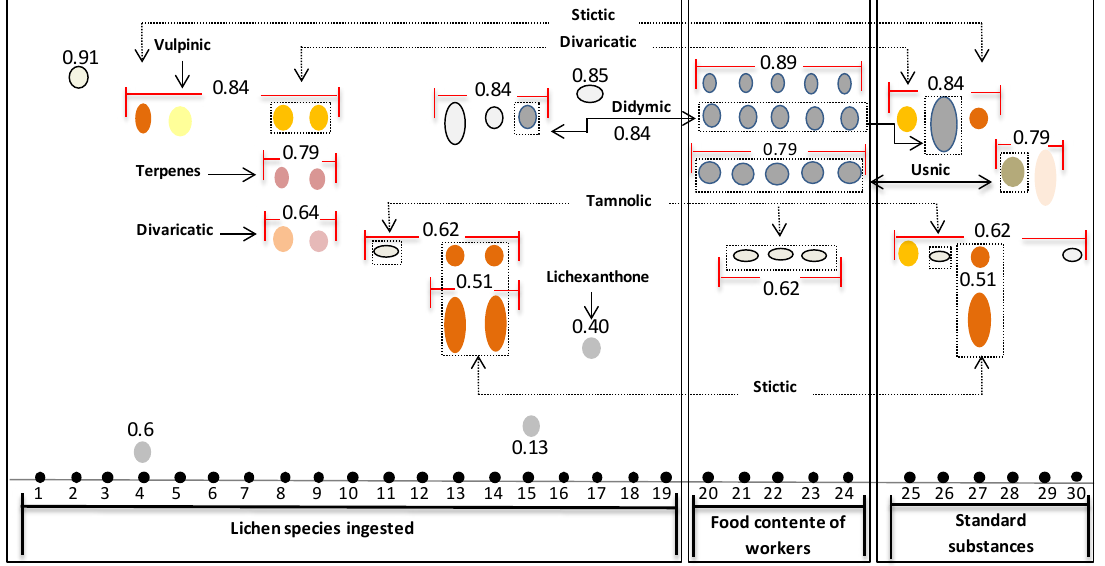
Fig 3. Thin layer chromatography of lichens organic extracts ingested by Constrictotermes cyphergaster and crop food content of workers during foraging in wet season (2013) in a semiarid region of northeastern Brazil. Chromatography points: 1-19: (Lichens): 1- Anisomeridium albisedum ; 2- Arthonia sp; 3- Arthopyrenia cinchonae ; 4- Canoparmelia sp.; 5- Chrysothrix xanthina ; 6- Clandestinotrema sp.; 7- Coniocarponcin nabarinum ; 8- Dirinaria confluens ; 9- D. leopoldii ; 10- Glyphis scyphulifera ; 11- Graphis cincta ; 12- Mycoporumes chweiler; 13- Lecanora leprosa ; 14- Leucodecton occultum ; 15- Pertusaria flavens ; 16- Polymeridium albocinereum ; 17- P. amyloideum ; 18- P. subcinereum ; 19- Pyrenula anomala . 20 to 24: (Food contents of the workers who ate lichens): 20- Nest Population 1; 21 - Nest Population 2; 22- Nest Population 3; 23- Nest Population 4; 24- Nest Population 5. 25-30: (Standards substances): 25- Divaricatic acid; 26- Tamnolic acid and didymic; 27- Stictic acid; 28- Usnic acid; 29- Atranorin; 30-